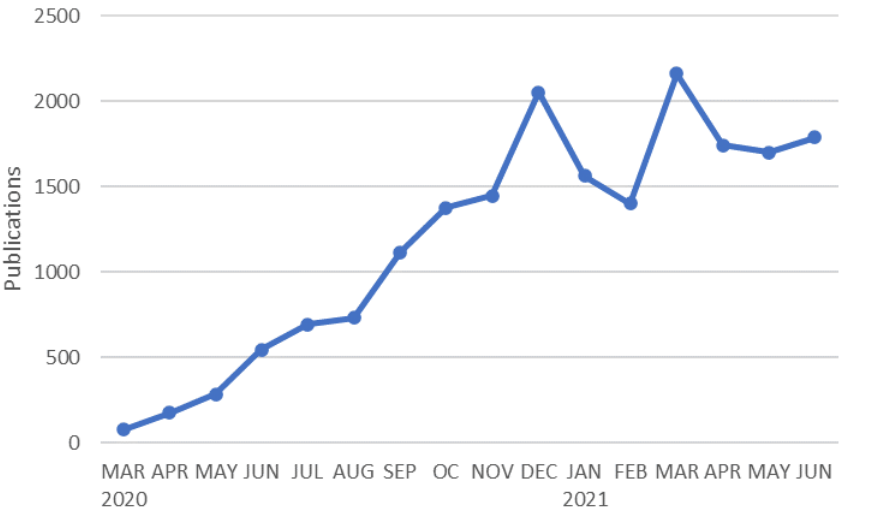
Figure 1. Temporal evolution of the number of publications related to emerging technologies and COVID-19 (source Scopus).